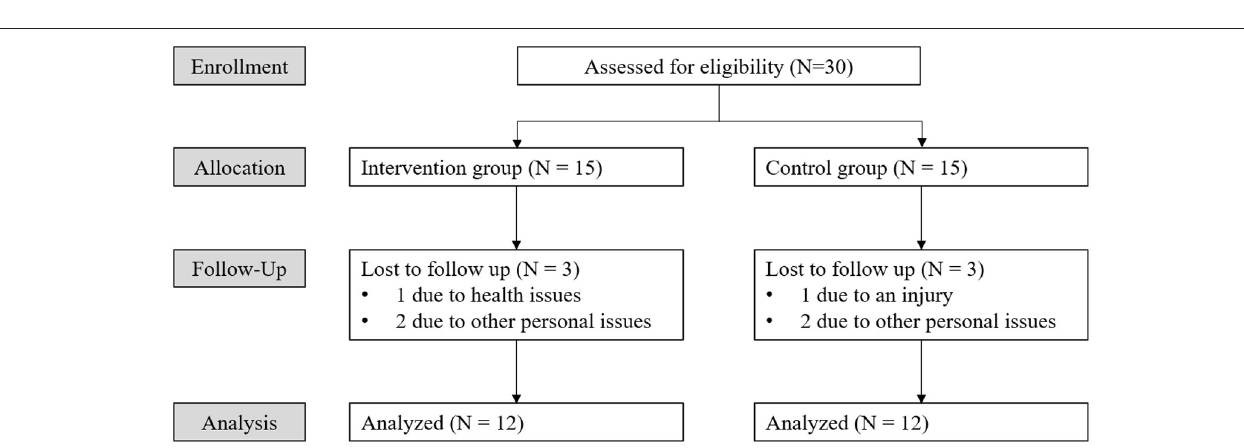
FIGURE 2 | Consolidated standards of reporting clinical Trial (CONSORT) flowchart representing status of participants through the 8-week